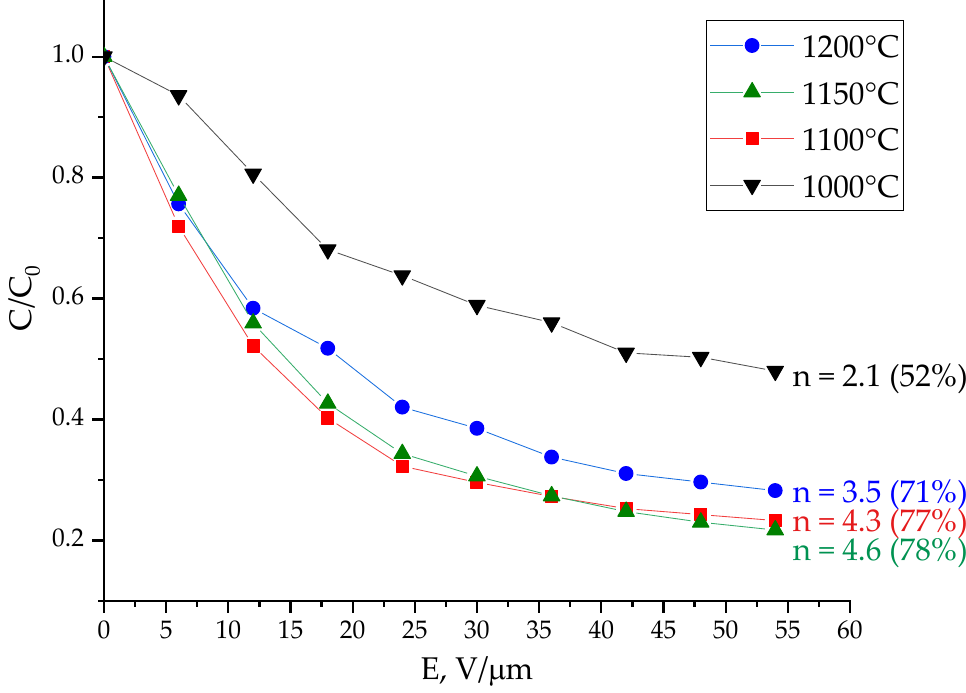
Figure 6. Voltage–capacitance characteristics of planar capacitors based on BZT films subjected to annealing at various temperatures.